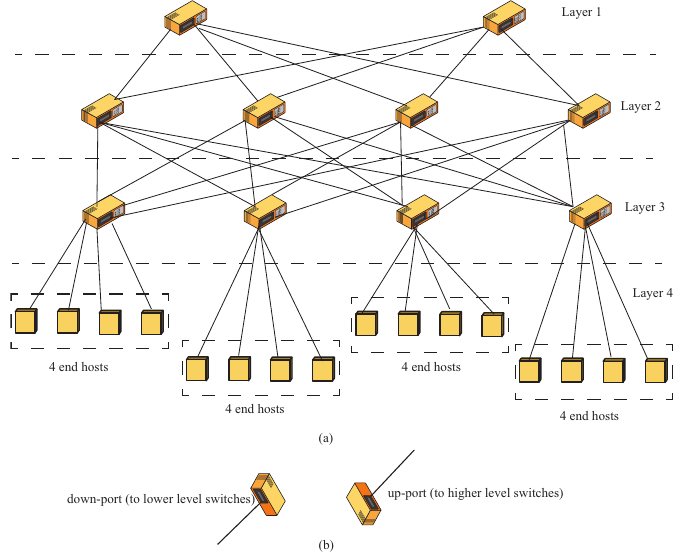
Figure 1. ( a ) A three layer fully-populated network, ( b ) Up and down